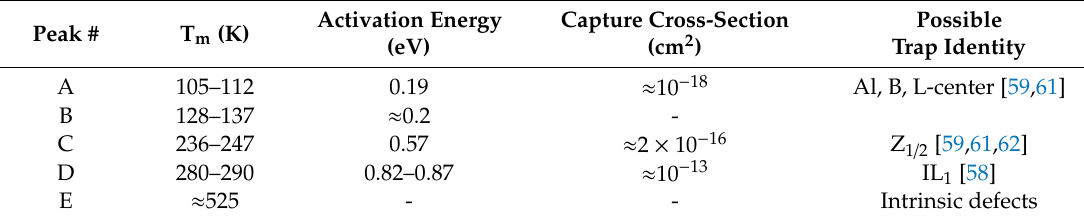
Figure 19. Arrhenius plots obtained from TSC spectra of a SI 4H-SiC (SI-M50) epitaxial layer at 0V bias. voltage. Table 2. Defect parameters acquired from TSC spectroscopy for a SI Ni / 4H-SiC